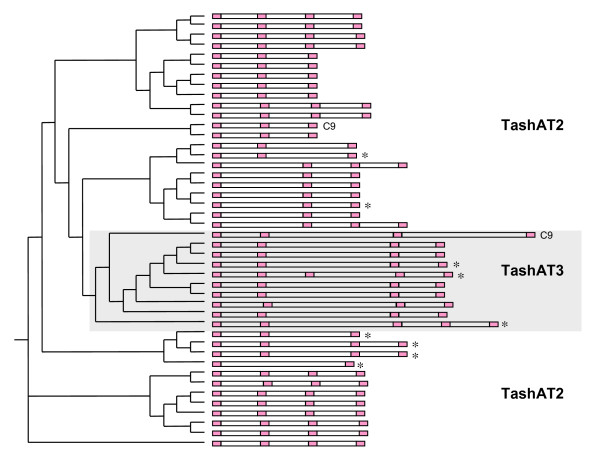
TashAT2 and TashAT3 AT-hook domains. The AT-hook domains of TashAT2 and TashAT3 were aligned and used to generate a neighbour-joining tree. The figure illustrates the number of AT-hooks (indicated in pink) and the distance between core 'GRP' motifs for each allele. Tunisian sequences are indicated by an asterisk.